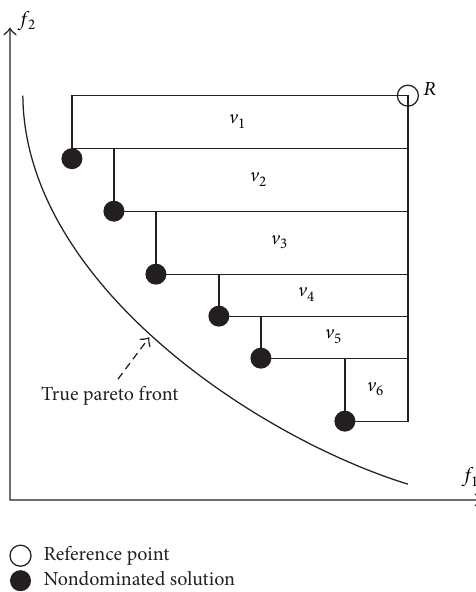
Figure 4: Hypervolume measure with area covered by the nondom- inated solutions and a reference